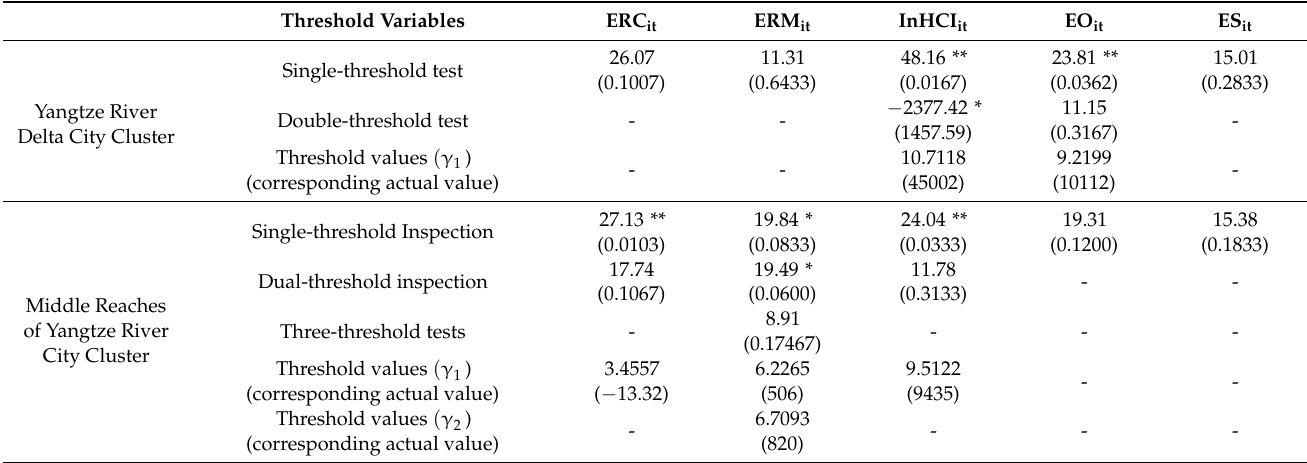
Table 6. Threshold effect test and estimation